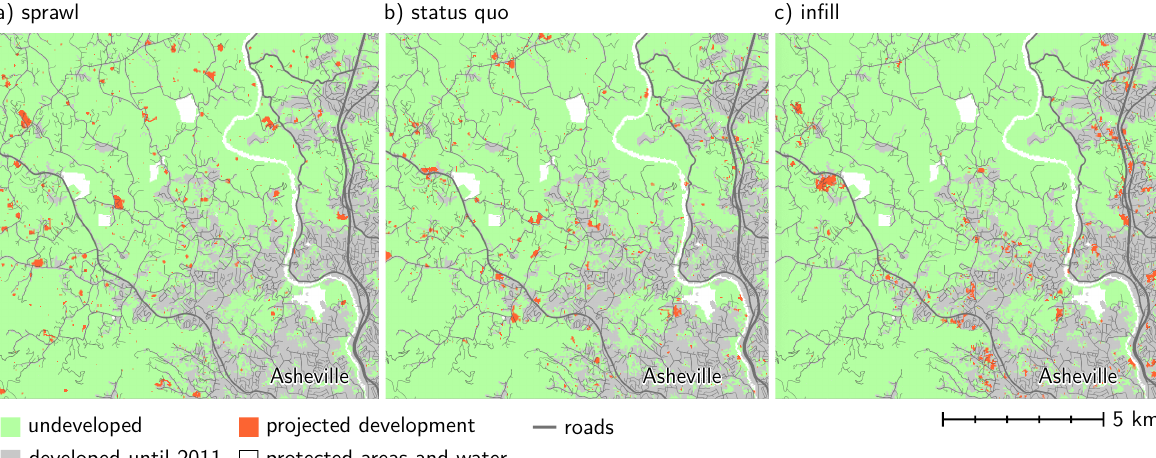
Figure 5: Results of three realizations of multiple stochastic runs with different scenarios. Depending on the scenario, simulated development is more diffuse (a) or more compact (c).